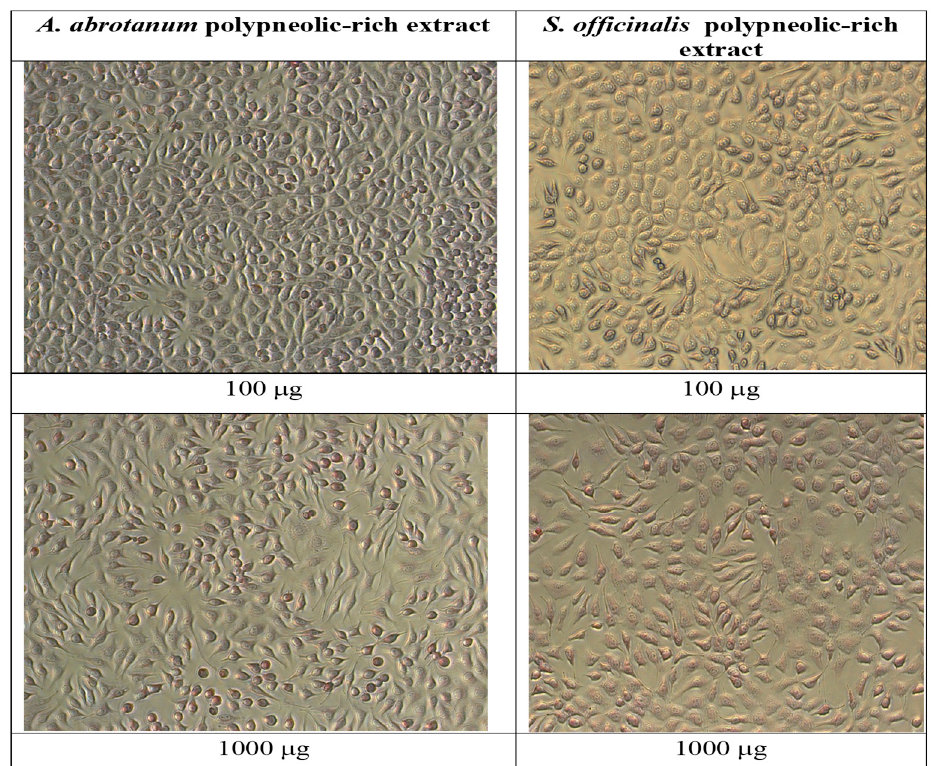
Figure 5. Normal NCTC cell line.